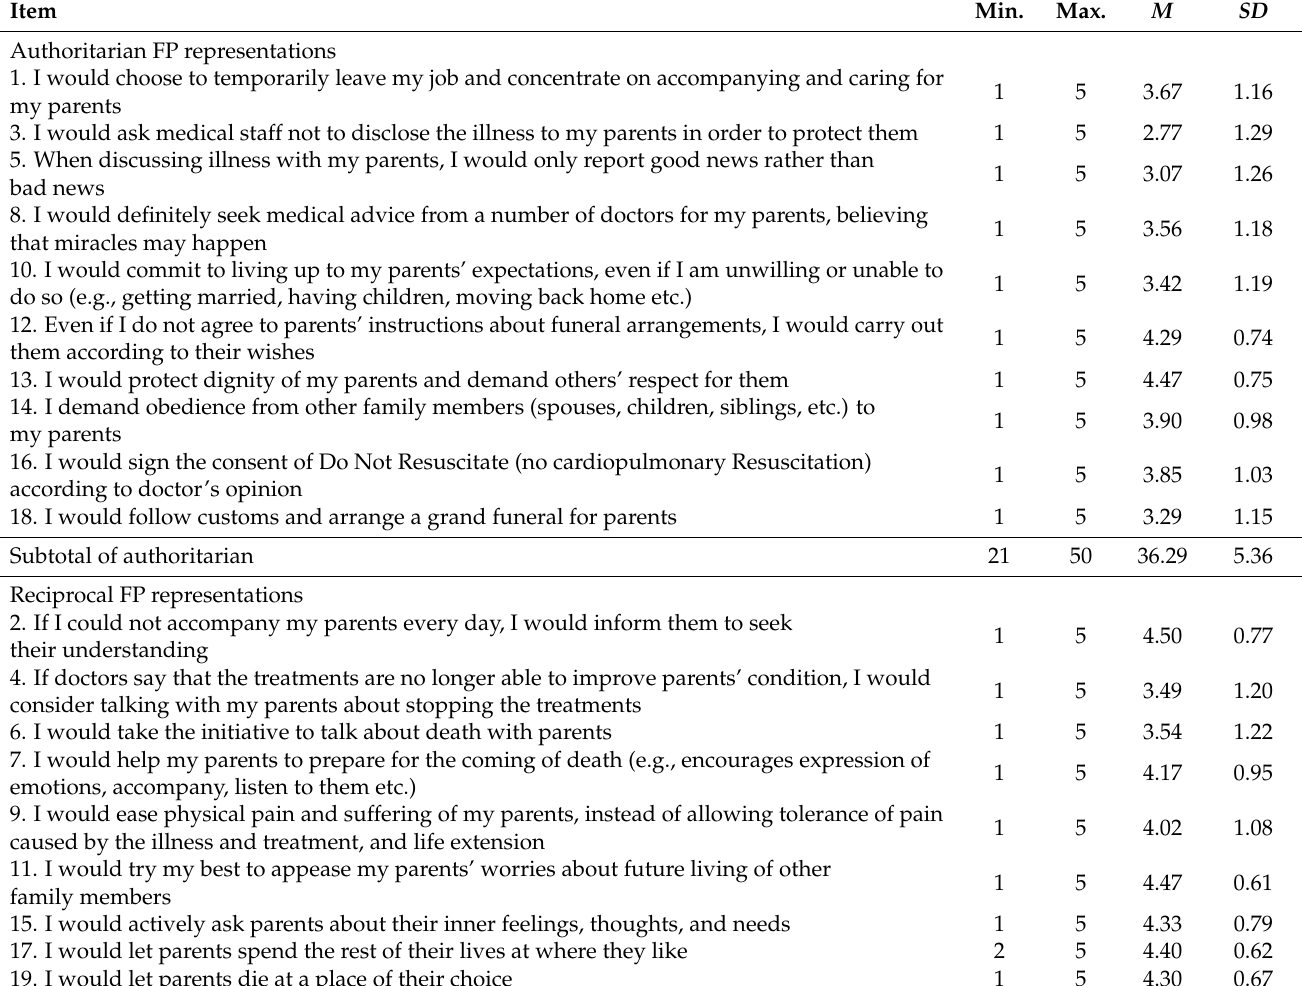
Table 2. Results of FPR-EoL Scale Items ( n = 705).